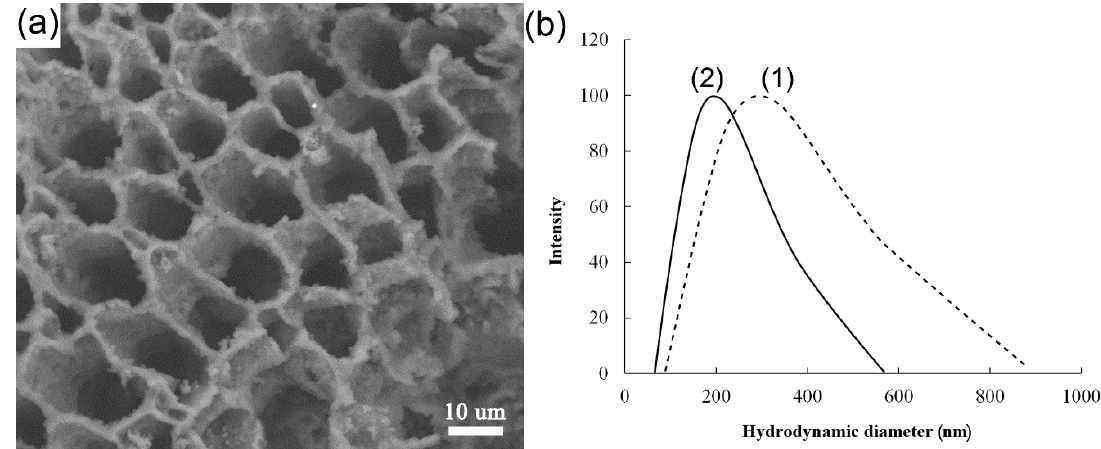
Figure 1. ( a ) SEM image of PVT and ( b ) particle size distribution curves of the ( 1 ) initial PVT and ( 2 ) AgNPs